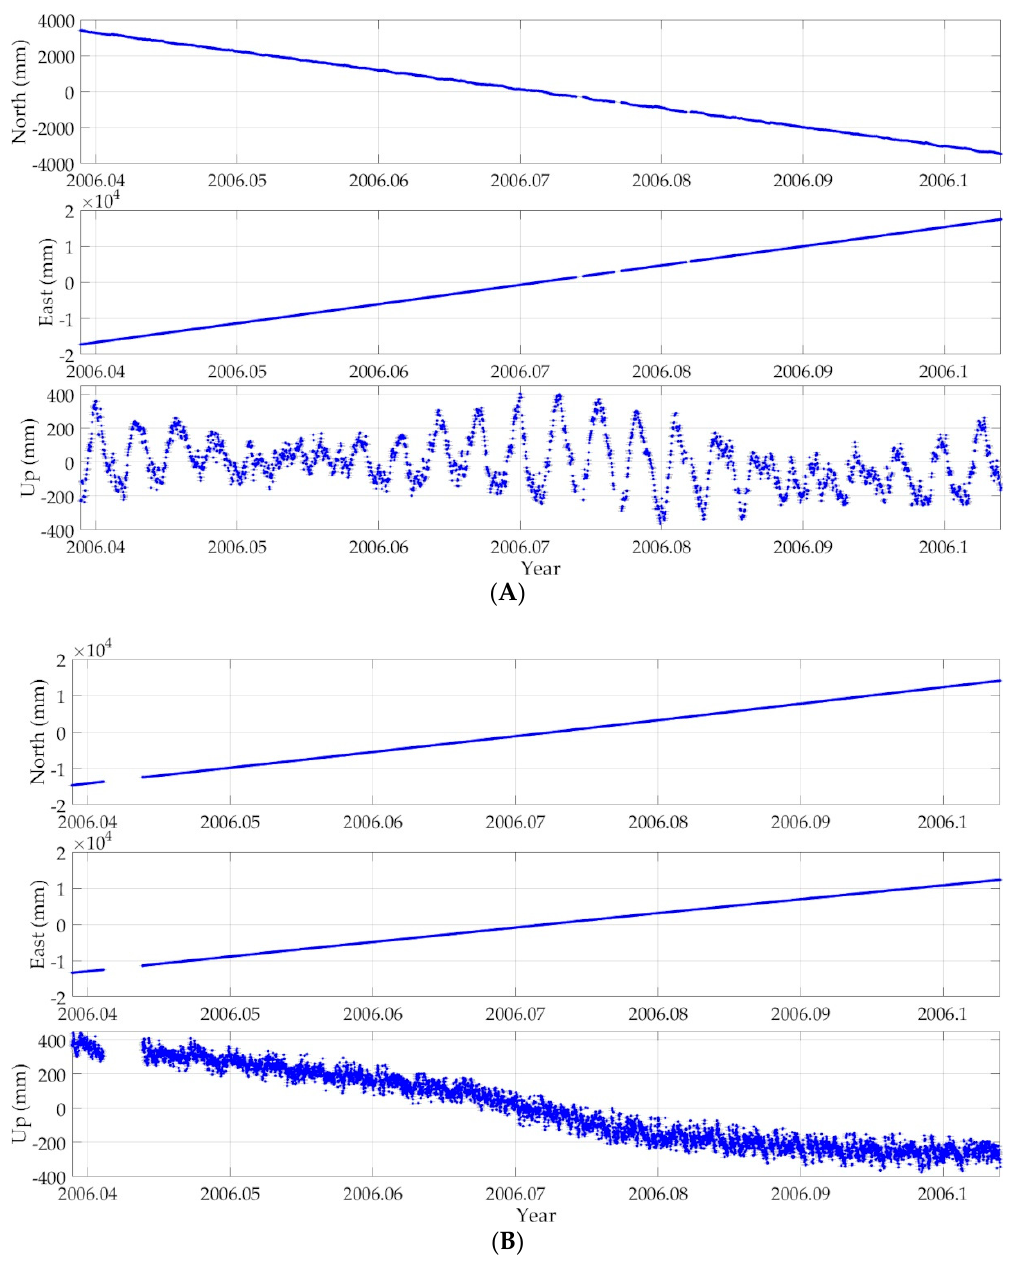
Figure 3. Local geodetic coordinate system time series of GNSS stations DRY1 ( A ) and ICF1 ( B ); time scale in years.